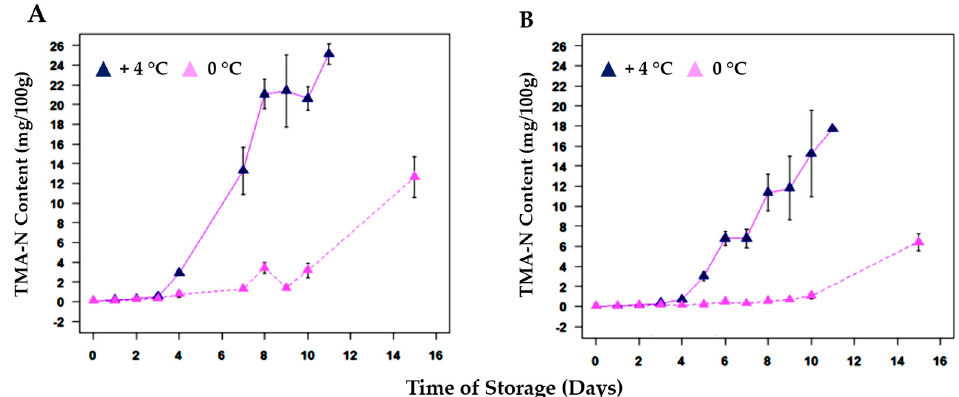
Figure 1. Kinetic of TMA-N concentrations (mg/100 g) for ( A ) red mullet ( Mullus barbatus ) and ( B ) bogue ( Boops boops ) samples during the storage at both +4 ◦ C and 0 ◦ C. All the concentrations were calculated via NMR by using the protocol fine-tuned by Ciampa et al. [8]. Red mullets stored at +4 ◦ C showed a higher concentration of TMA-N after 11 days (T11) of storage than bogue samples stored under the same conditions. This can be